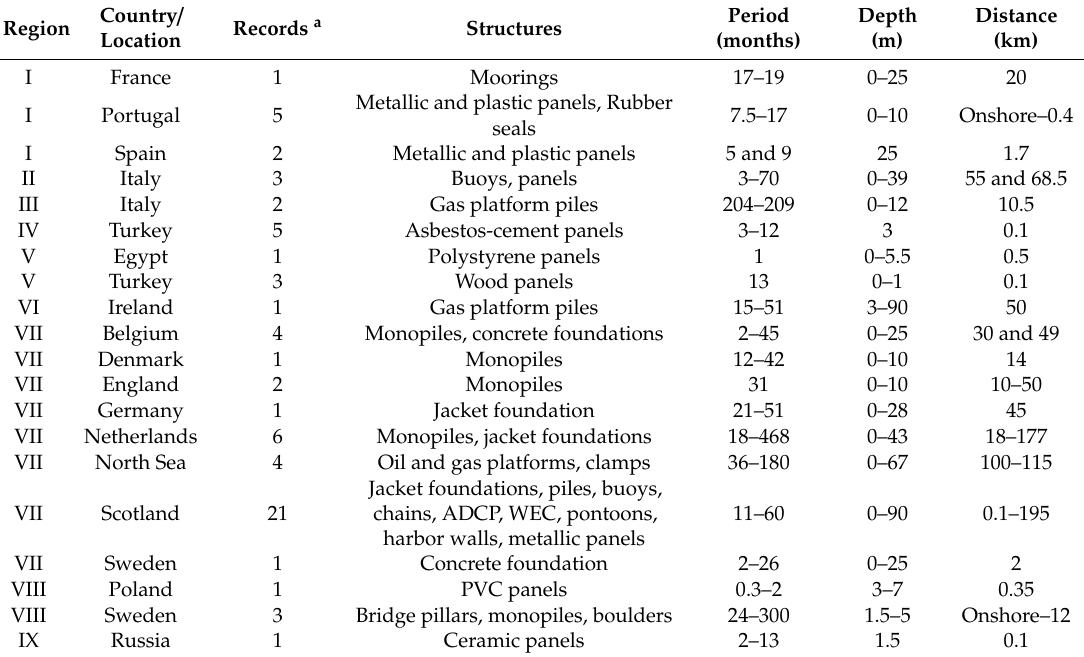
Table 3. Overview of the origin of the data used to generate the biofouling